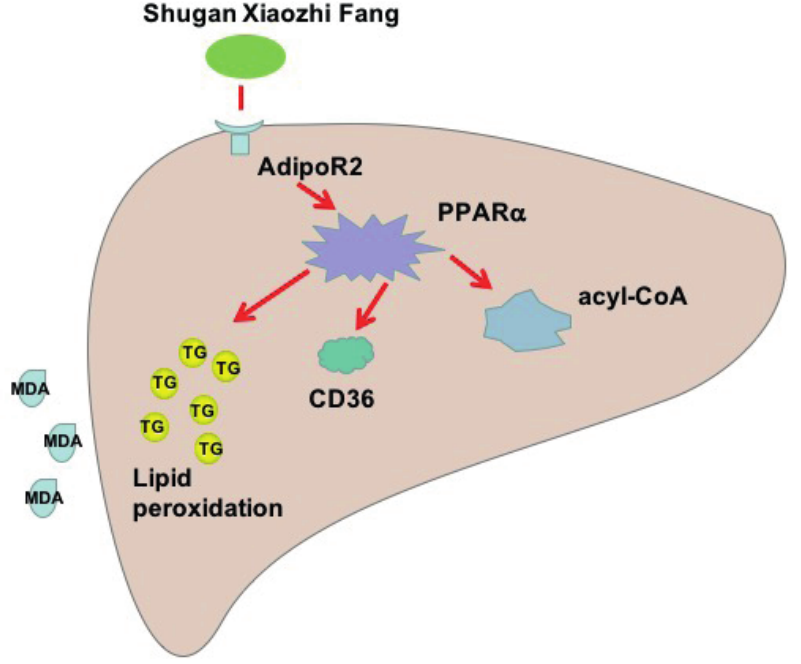
Figure 7: A schematic diagram of mechanism of Shogun Xiaozhi Fang for reducing serum TG and MDA levels.. Shugan Xiaozhi Fang activated the AdipoR2-PPARα-CD36/acyl-CoA signaling pathway. In the liver, Shugan Xiaozhi Fang can upregulate the expression of the PPARα target gene and regulate fatty acid metabolism, such as induction of lipid transporter CD36 gene expression, as well as lipid uptake and transport. It can also upregulate acyl-CoA gene expression and fatty acid